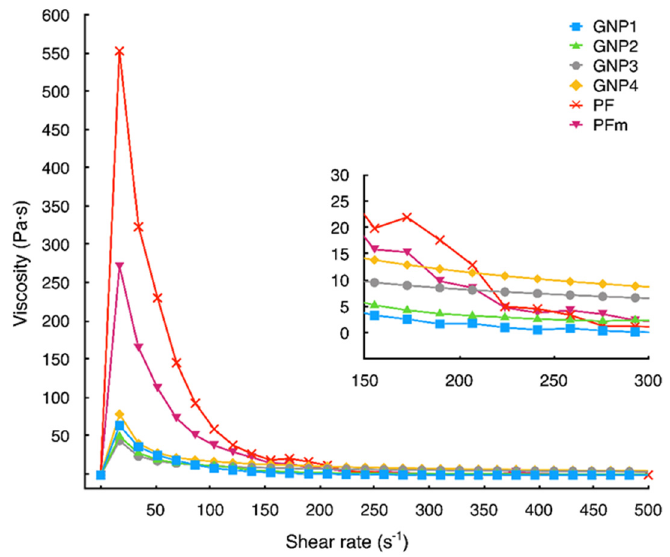
Figure 4. Viscosity curves for the examined pastes; inset—magnification of the curves in the shear-rate range corresponding to pastes squeezing through the printing screen.